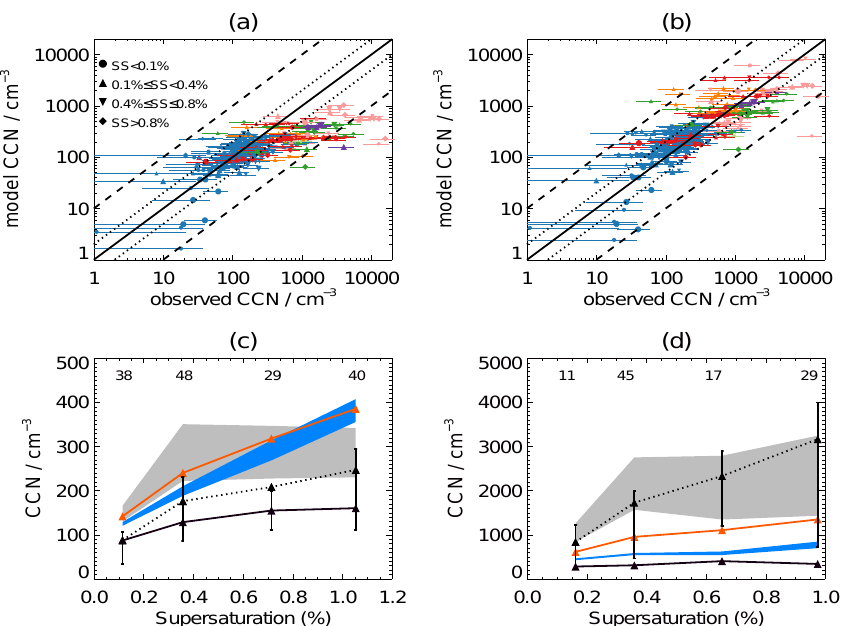
Fig. 2. Observed and simulated CCN. Simulations are (a) without, (b) with carbonaceous combustion aerosol acting as CCN. Observations (10–31 days sampling: large symbol, < 10 days: small symbol; error in observations represented by error bars, see text) with colour indicating location (colour scale matches Fig. 1a). Solid line is the 1:1 relationship, dotted lines are the 2:1 and 1:2 relationships, dashed lines are the 10:1 and 1:10 relationships. Lower panels show CCN binned by supersaturation ( S ) (0.02 ≤ S /% < 0.15; 0.15 ≤ S /% < 0.3; 0.3 ≤ S /% < 0.6, 0.6 ≤ S /% < 1.6, with number of observations per bin shown in panel) for (c) clean (simulated BC < 50ngm − 3 ), (d) polluted (BC > 100ngm − 3 ) conditions. Observations (mean: dotted line; 25th to 75th percentiles: error bars) and simulations (without carbonaceous combustion aerosol acting as CCN: black line; as above but including BL nucleation: blue shading shows uncertainty due to nucleation rate; as above but with maximum likely contribution of primary sulfate: red line; with carbonaceous combustion aerosol acting as CCN: grey shading due to uncertainty in emitted particle size). Model values are calculated from the simulations described in Table 3.